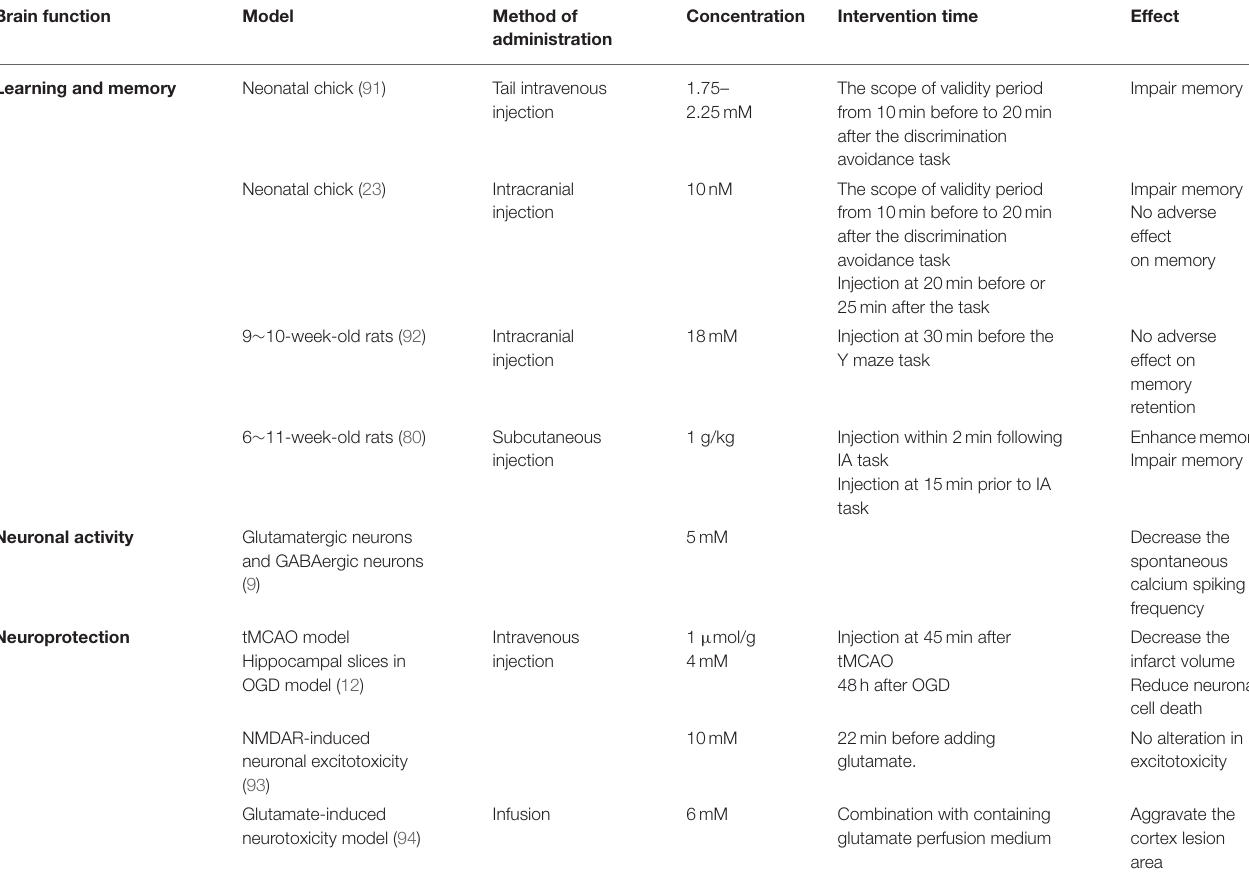
TABLE 1 | The effect of D-lactate on the brain